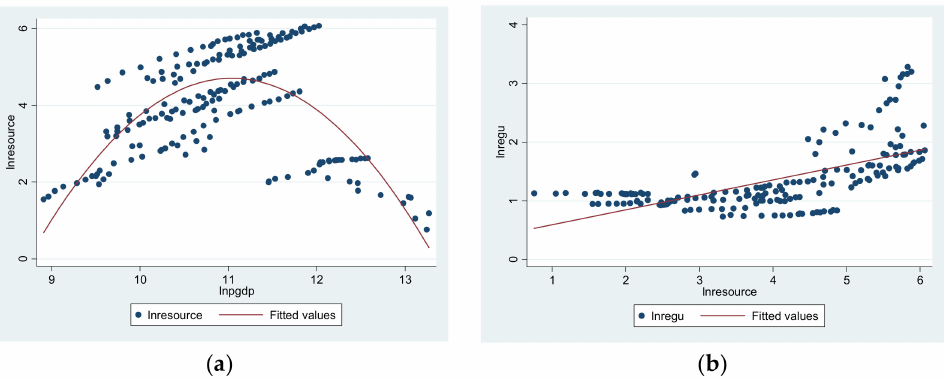
Figure 3. ( a ) The relationship between the economic development and resource consumption. ( b ) The relationship between the resource consumption and environmental